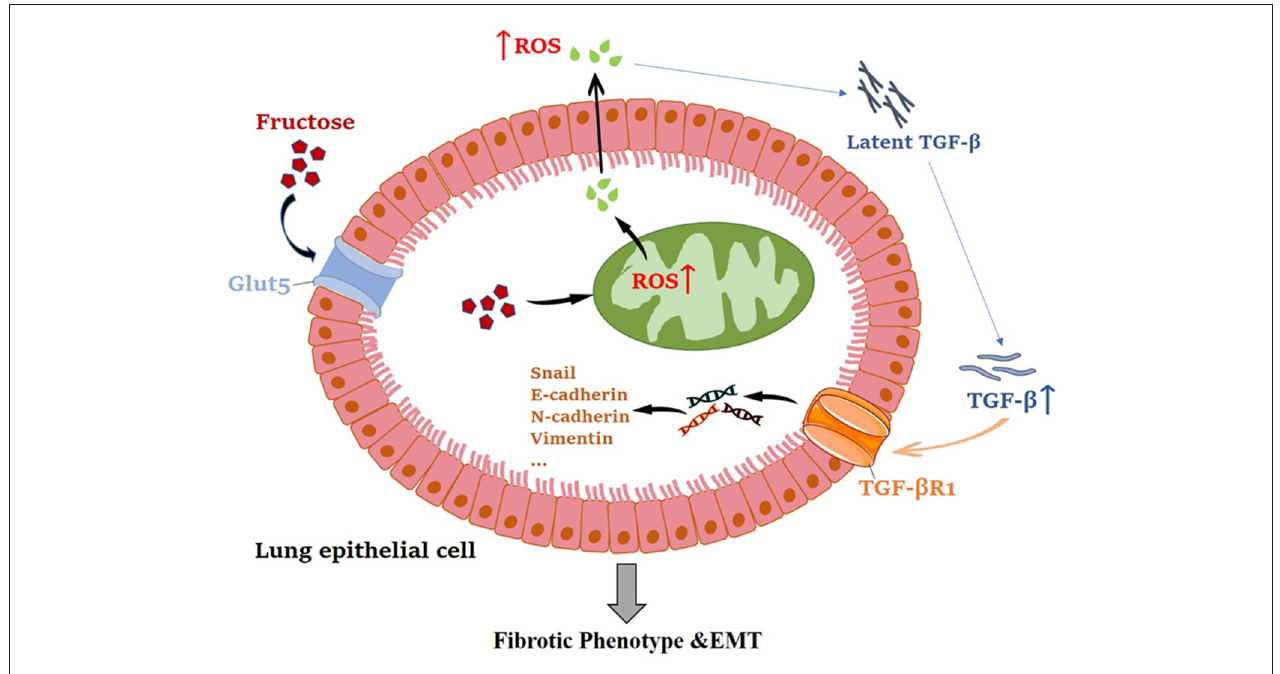
FIGURE 11 | The mechanism of fructose promoting pulmonary epithelial cell fibrosis and